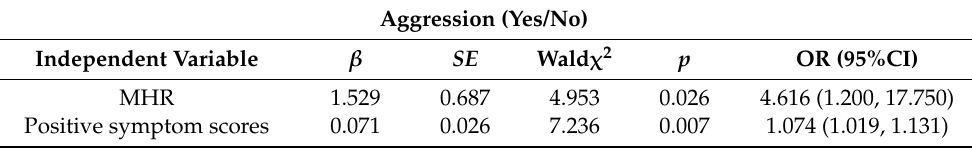
Table 4. Multivariate analysis of aggressive behavior.